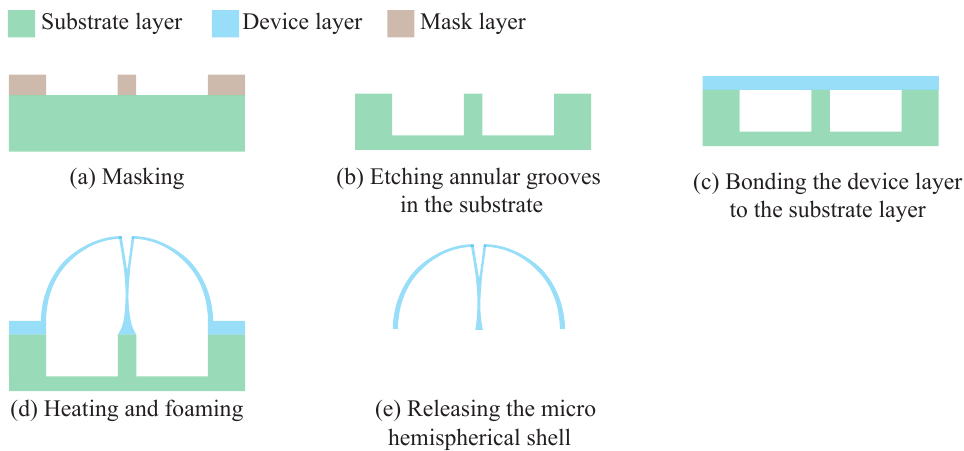
Figure 2. Concept schematic of fabrication process for microhemispheric shell based on the surface tension